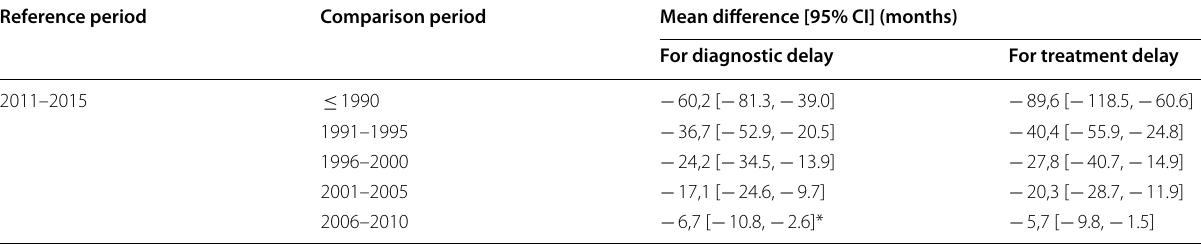
RA, rheumatoid arthritis; CI, confidence interval * p 0.002; all other differences shown in the table were significant at p < 0.001 on Games-Howell post-hoc tests following one-way =